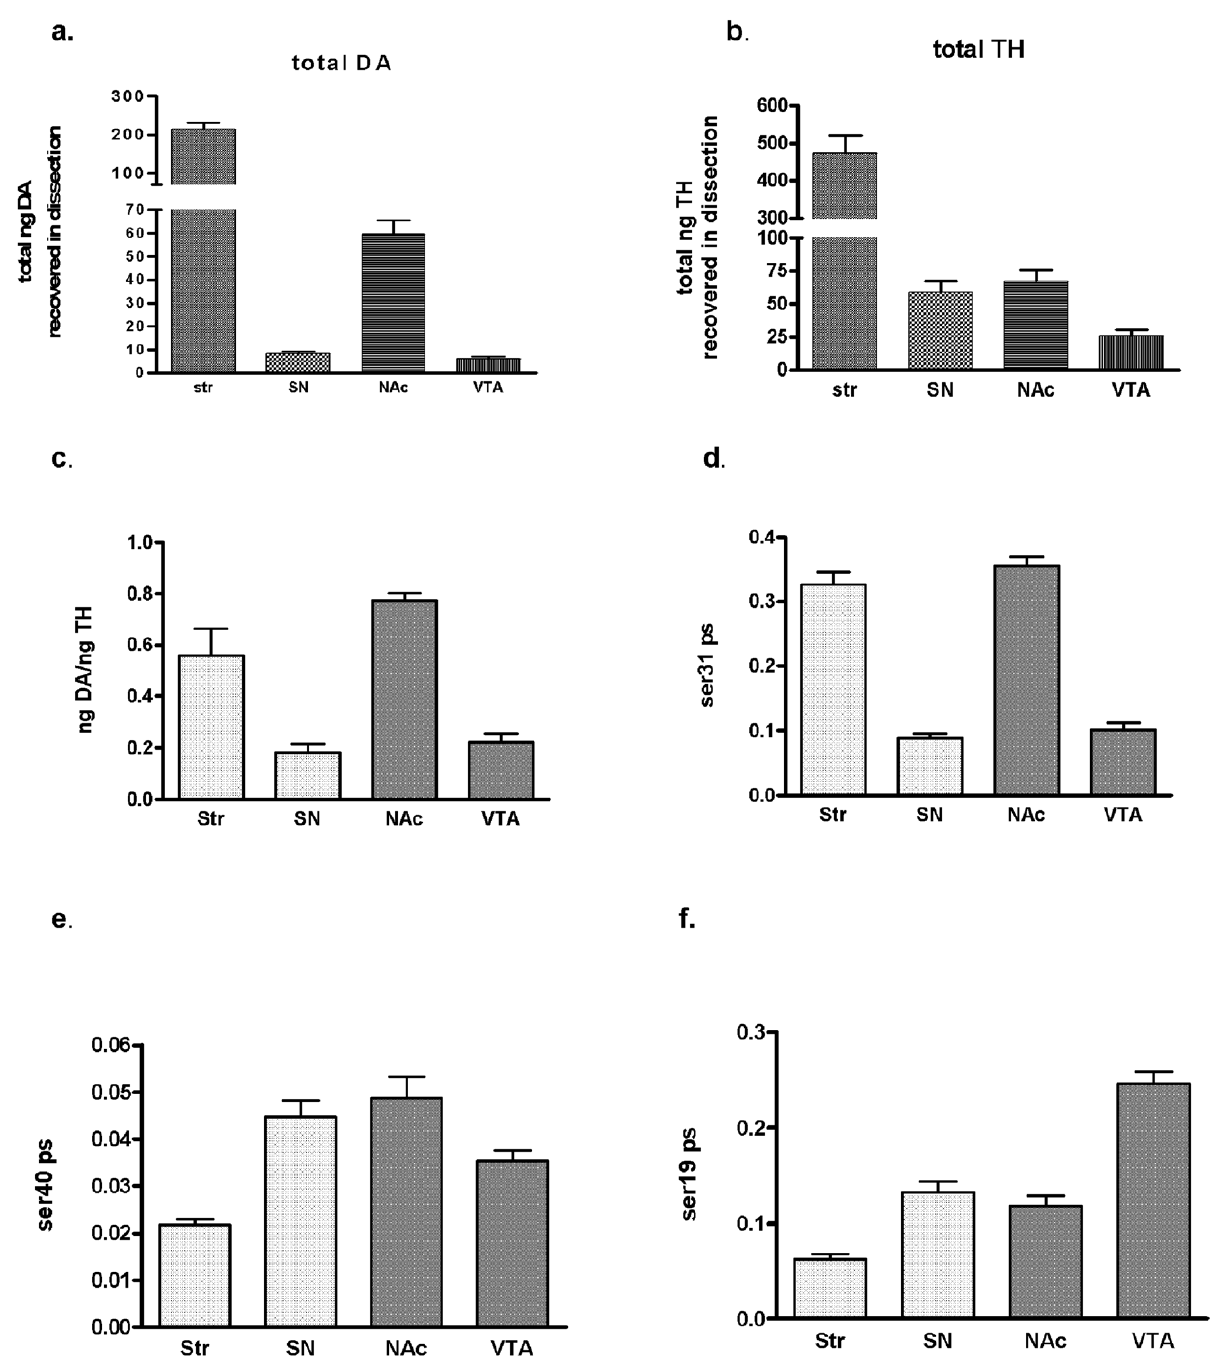
Figure 1. Dopamine, tyrosine hydroxylase protein, and phosphorylation stoichiometry (ps) comparisons in nigrostriatal and mesoaccumbens pathways. Analyses of striatum (str), substantia nigra (SN), nucleus accumbens (NAc), and ventral tegmental area (VTA) from all test subjects ( n =14, seven pairs of 12 and 30 month old rats from locomotor study). a. total DA recovery The mean relative total recovery of DA (in ng) was Str=214 6 16; SN=8.4 6 0.8; NAc= 59.6 6 5.8; VTA=6.0 6 1.0. b. total TH protein recovery The mean TH recovery (in ng) was Str=473 6 49; SN=59 6 9; NAc=68 6 9; VTA=26 6 5. c. TH-Normalized DA tissue content Str 0.56 6 0.11, SN 0.18 6 0.03, NAc 0.77 6 0.03, VTA 0.22 6 0.03. There was a significant difference in DA recovered per TH among the four regions (ANOVA (p , 0.0001) and between Str and SN ( p , 0.001), Str and VTA ( p , 0.01), SN and NAc ( p , 0.001), and VTA and NAc ( p , 0.001). d. ser31 phosphorylation stoichiometry (PS) Str 0.33 6 0.02, SN 0.09 6 0.01, NAc 0.36 6 0.01, VTA 0.10 6 0.01. There was a significant difference in ser31 phosphorylation among the four regions (ANOVA (p , 0.0001) and between Str and SN ( p , 0.001), Str and VTA ( p , 0.001), SN and NAc ( p , 0.001), and VTA and NAc ( p , 0.001). e. ser40 PS Str 0.022 6 0.001, SN 0.045 6 0.004, NAc 0.049 6 0.004, VTA 0.035 6 0.002. There was a significant difference in ser40 phosphorylation among the four regions (ANOVA (p , 0.0001) and between Str and SN ( p , 0.001), Str and NAc ( p , 0.001), Str and VTA ( p , 0.05), and NAc and VTA ( p , 0.05). f. ser19 PS Str 0.06 6 0.01, SN 0.13 6 0.01, NAc 0.12 6 0.01, VTA 0.25 6 0.01. There was a significant difference in ser19 phosphorylation among the four regions (ANOVA (p , 0.0001) and between Str and SN ( p , 0.001), Str and NAc ( p , 0.01), Str and VTA ( p , 0.001), SN and VTA ( p , 0.001) and NAc and VTA ( p , 0.001).